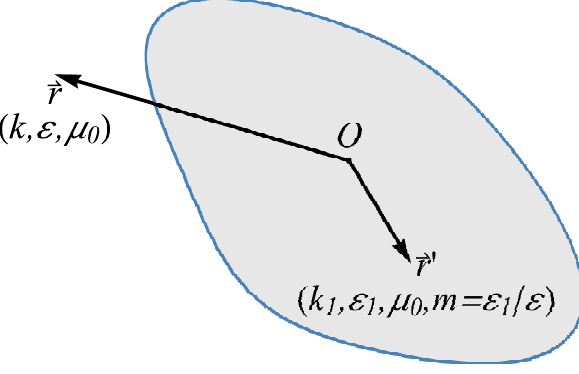
Figure 1. Parameters used for light scattering by a dielectric particle. The field point is outside the scattering particle with wavenumber k , permittivity ε , and permeability µ 0 and the point is inside the particle with wave number k 1 , permittivity